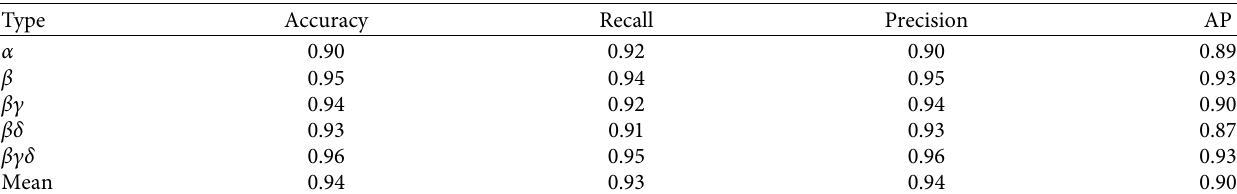
Table 2: The metrics of the test